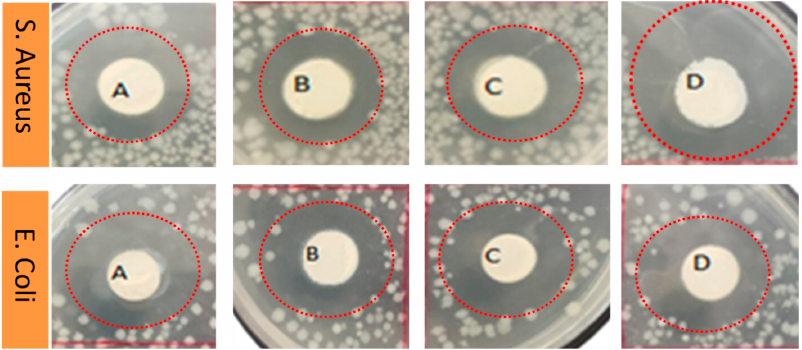
Figure 10. Antimicrobial activity of AV/PVA nanofibers (NFs). ( A ) 0.5% AV/PVA NFs; ( B ) 1.5% AV/PVA NFs; ( C ) 2.5% AV/PVA NFs; ( D ) 3% AV/PVA NFs.